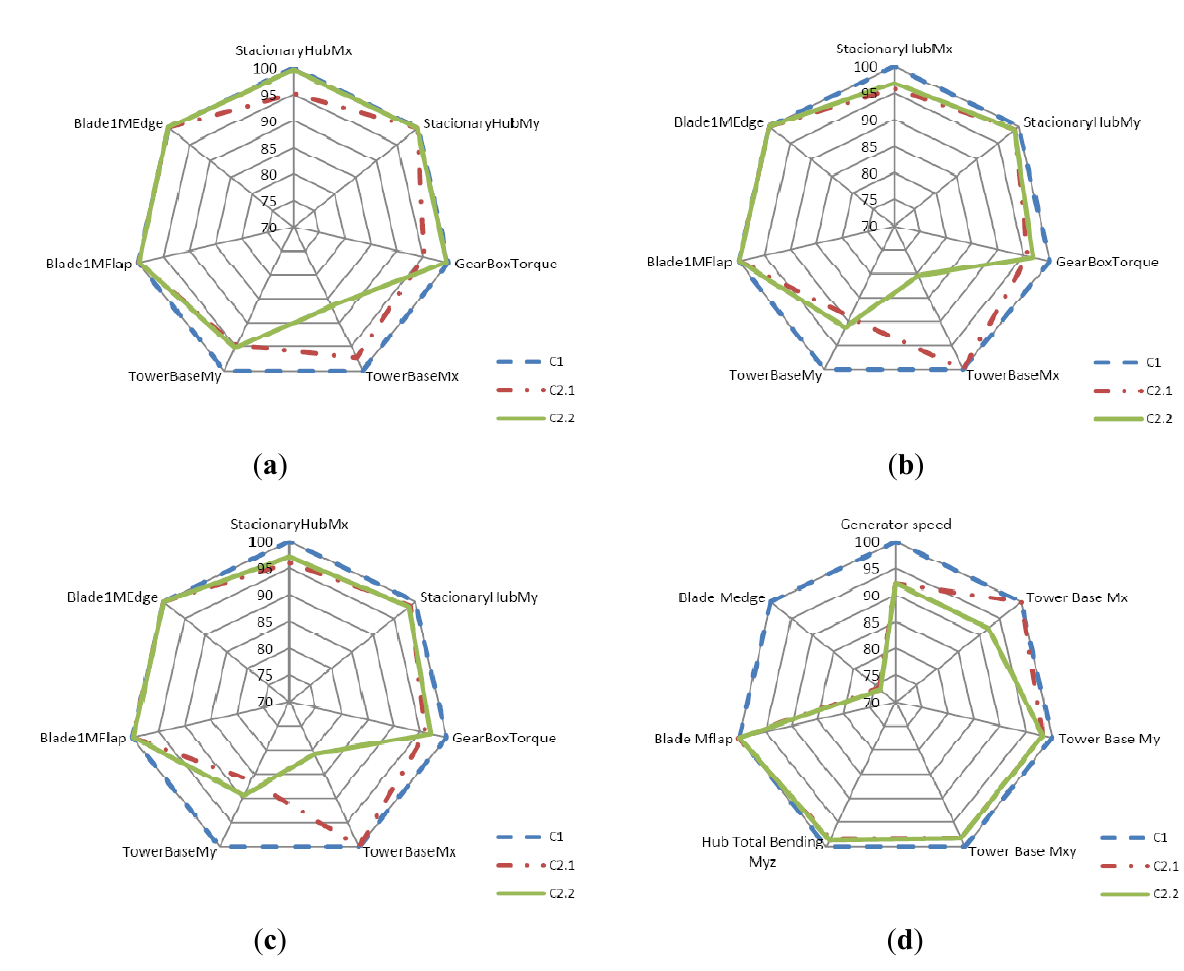
Figure 21. Review of load mitigation ( a ) Equivalent load analysis m = 3; ( b )